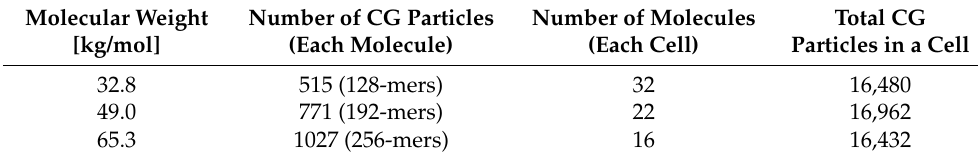
Table 3. Setup of simulation cells with various number-average molecular weights ( M n ).